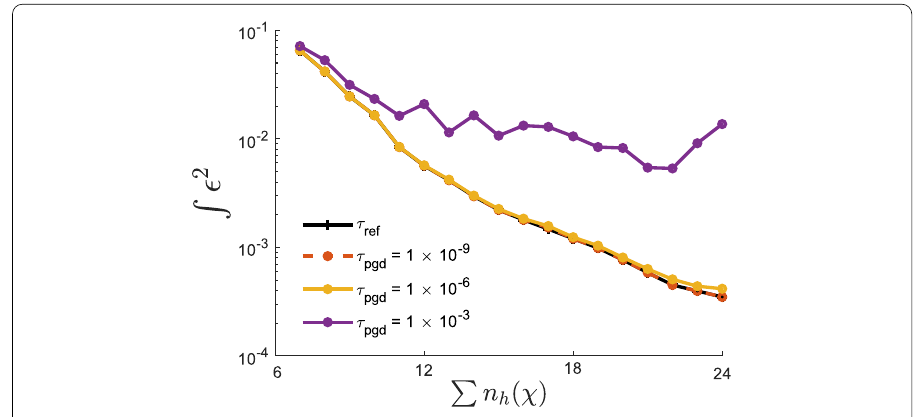
Fig. 12 Comparison between the reference simulation τ ref and the results with different tolerances for the integral of the energy of the error as a function of the element